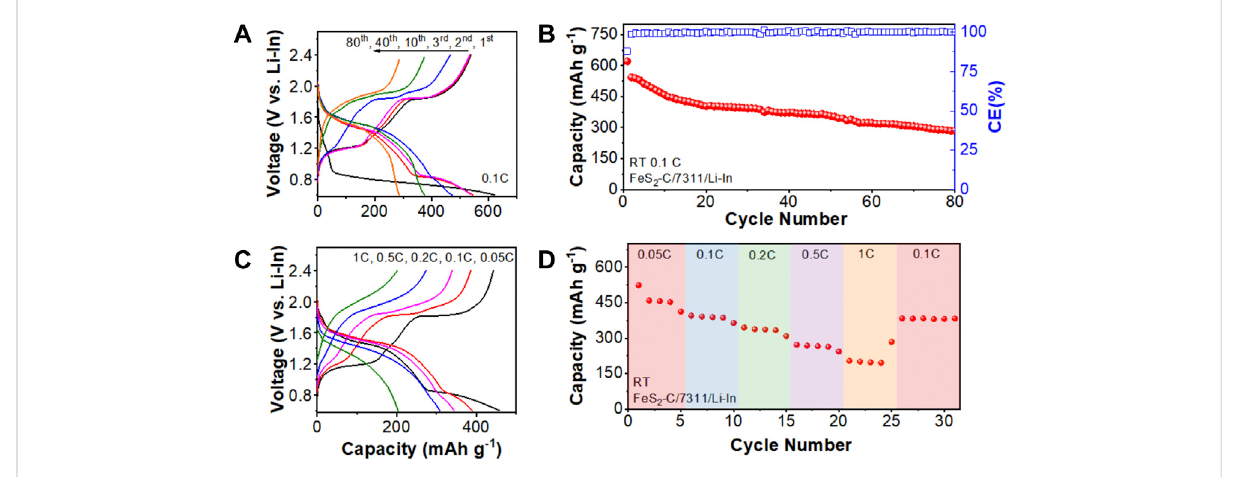
FIGURE 2 (A) The charge/discharge curves and (B) the corresponding cycling performances of the assembled FeS cycled at 0.1C. (C) The charge/discharge pro fi les of the above battery cycled at different C-rates and (D) the rate capability test results. All measurements were performed at room